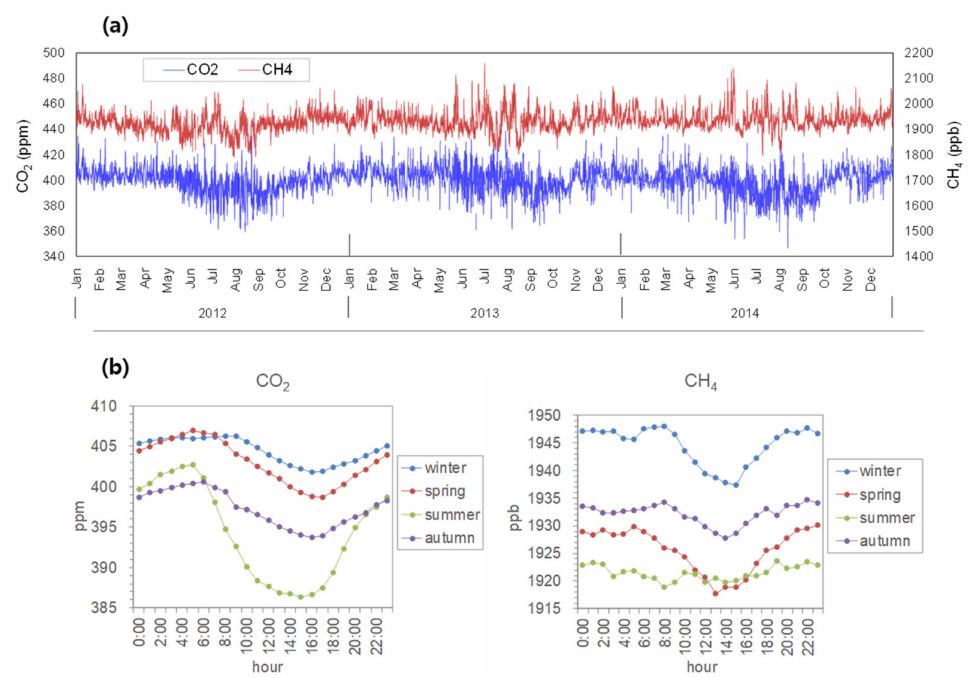
Figure 2. ( a ) Time series of hourly CO 2 and CH 4 concentrations and ( b ) diurnal variations of hourly average CO 2 and CH 4 at the GS station from 2012 to